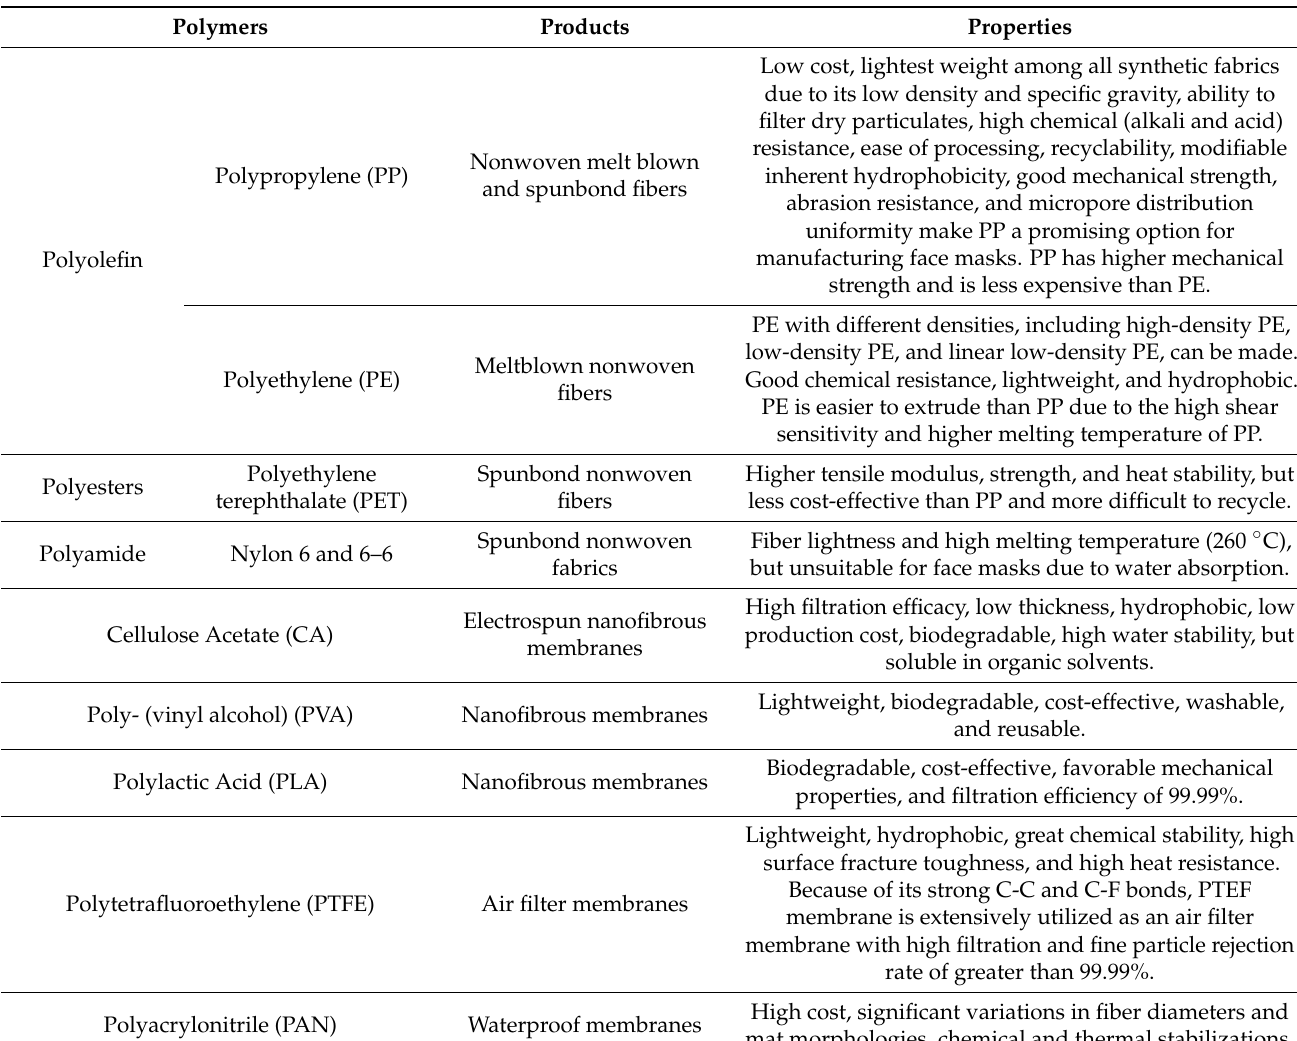
Table 3. Commonly used mask materials and their products and properties